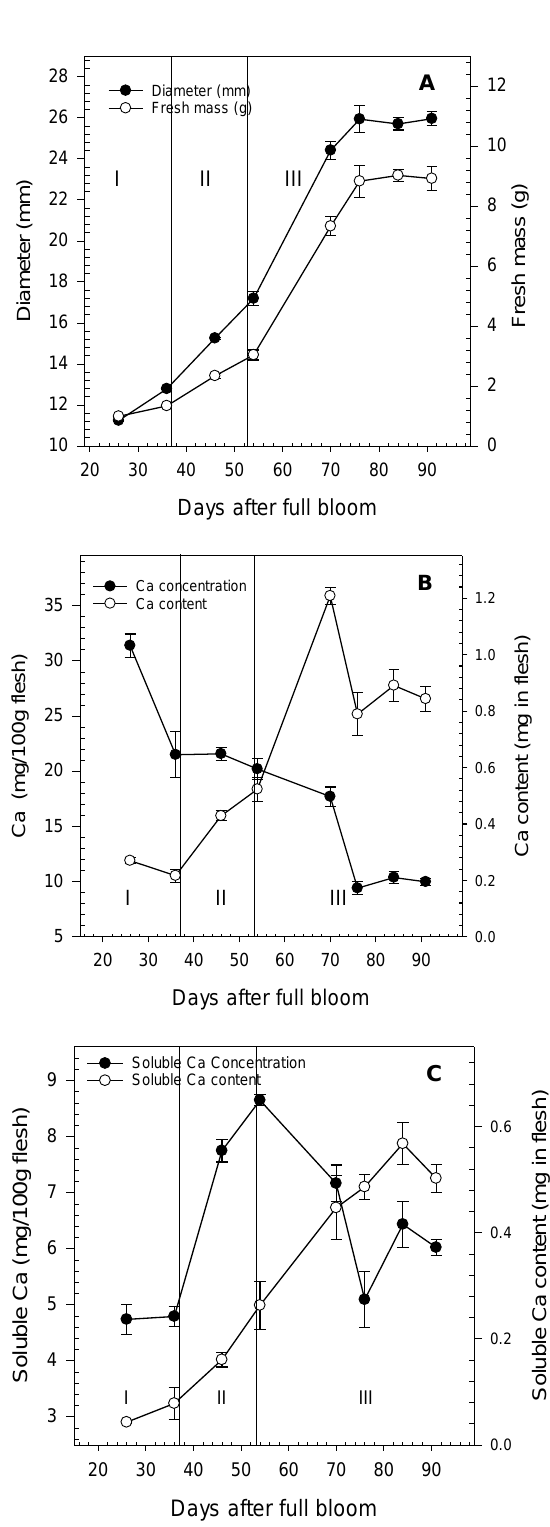
Figure 1. Calcium (Ca) accumulation patterns in fruits from trees with natural crop load and without foliar calcium chloride applications in the sweet cherry combination ‘Lapins’/‘Colt’. Each data point represents the mean ± SEM ( n = 4). ( A ) Equatorial diameter and fresh mass; ( B ) calcium concentration and total Ca content, and ( C ) soluble Ca concentration and total soluble Ca content.